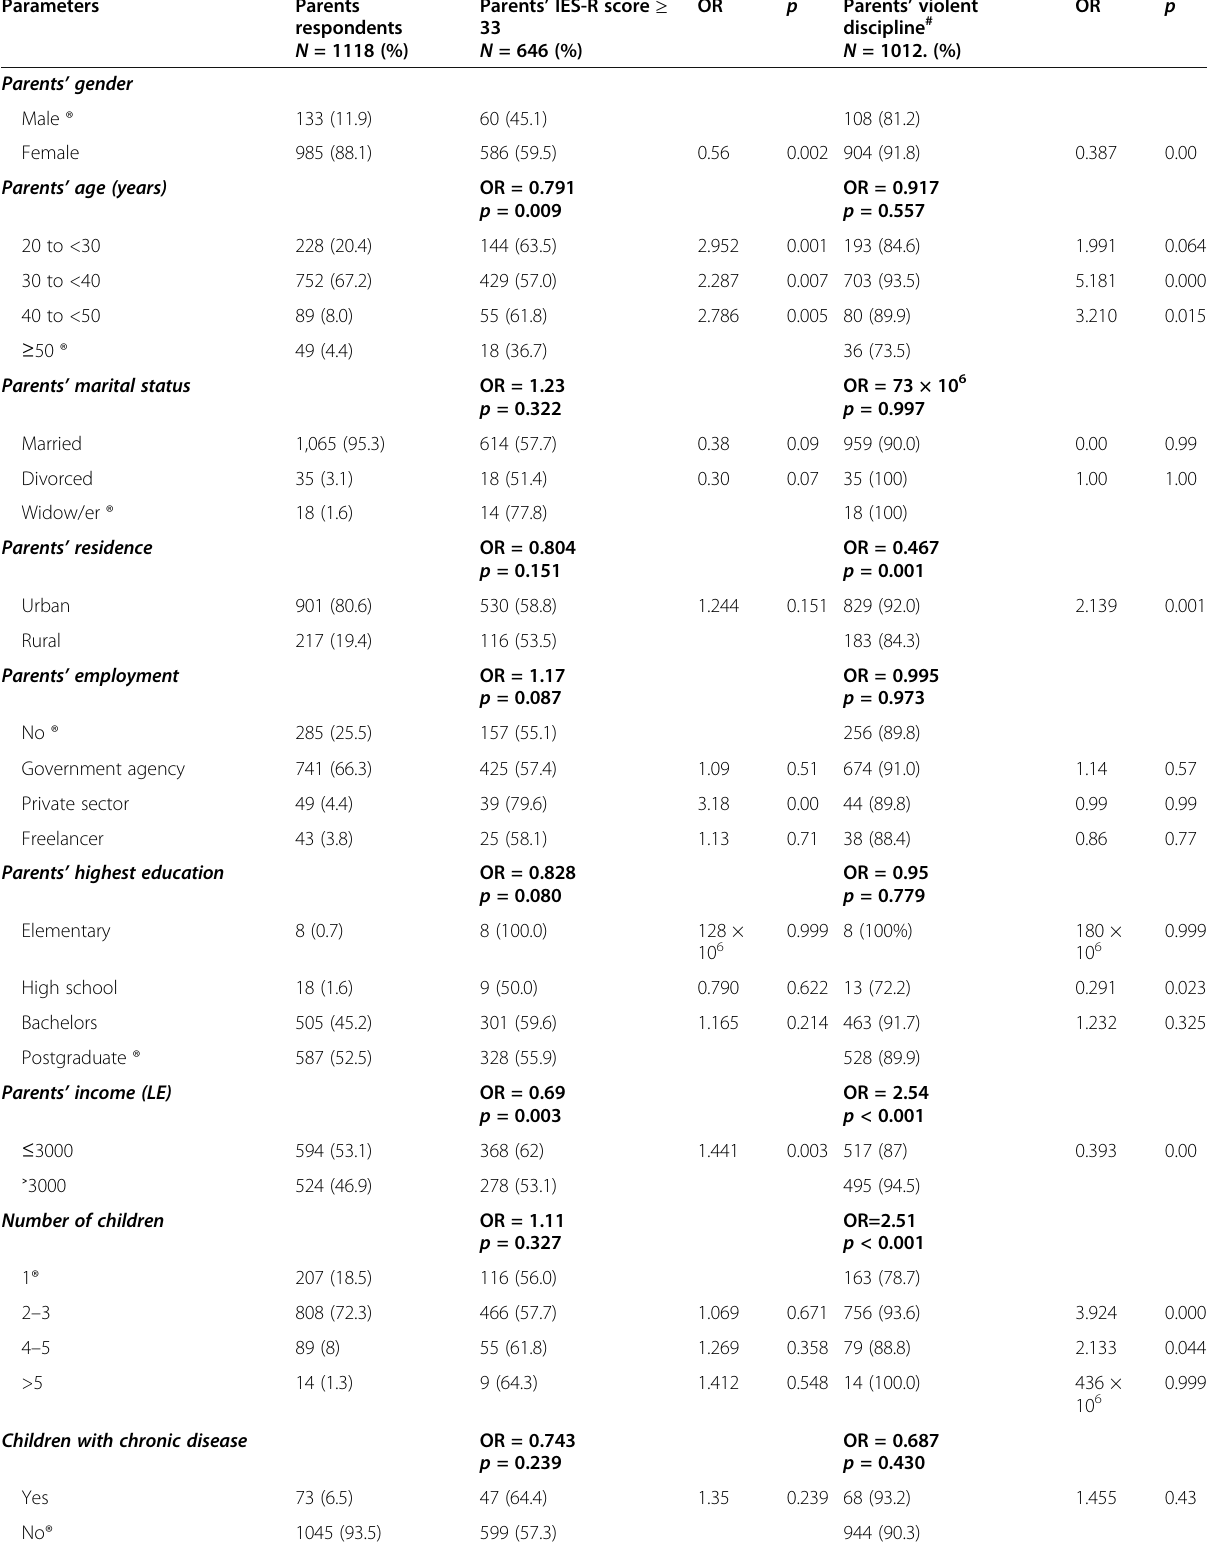
Table 1 Socio-demographic characteristics of survey respondents and their association with psychological impact of the pandemic on the parents and violent discipline against their children during the COVID-19 pandemic in Sohag governorate, Egypt, 2020